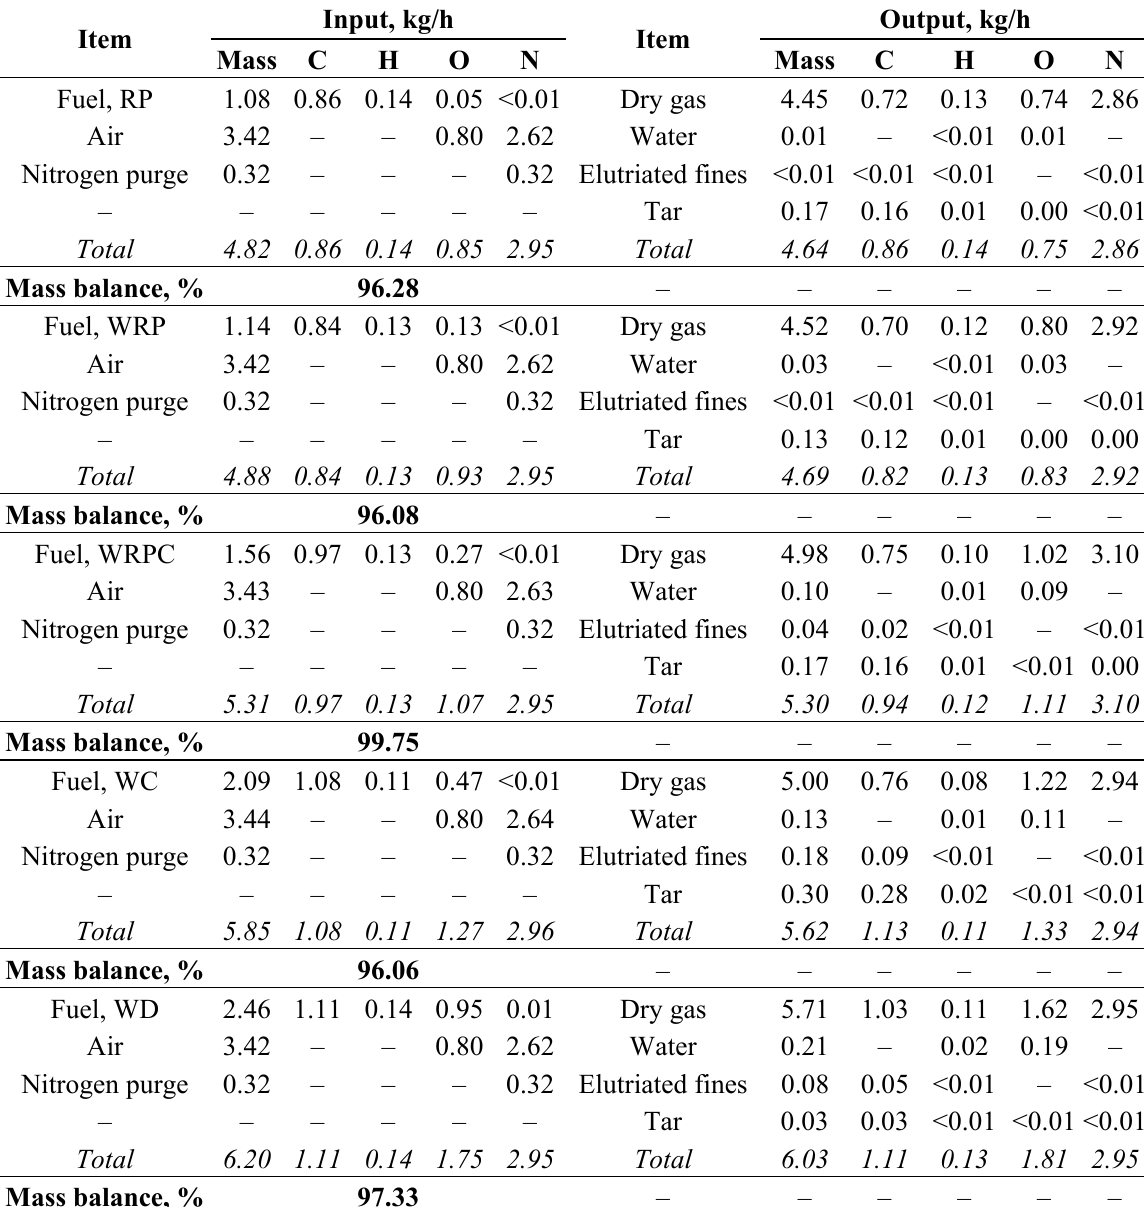
Table 6. Mass balance performed during the gasification